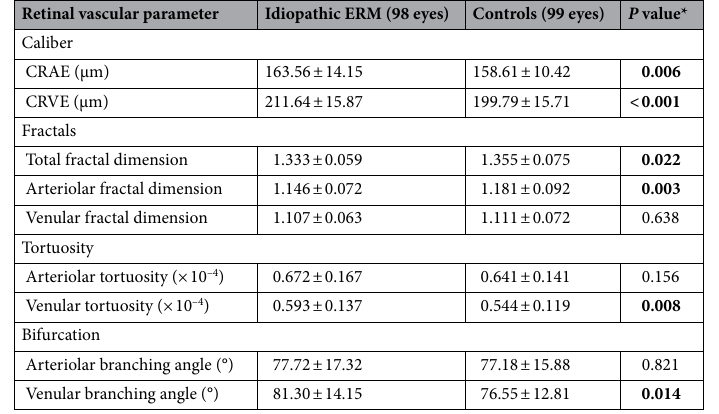
Table 2. Comparison of retinal vascular parameters between eyes with idiopathic epiretinal membrane and normal controls. CRAE central retinal arteriolar equivalent, CRVE central retinal venular equivalent, ERM epiretinal membrane. Continuous variables are reported as mean ± standard deviation. Significant factors appear in boldface. *Student t